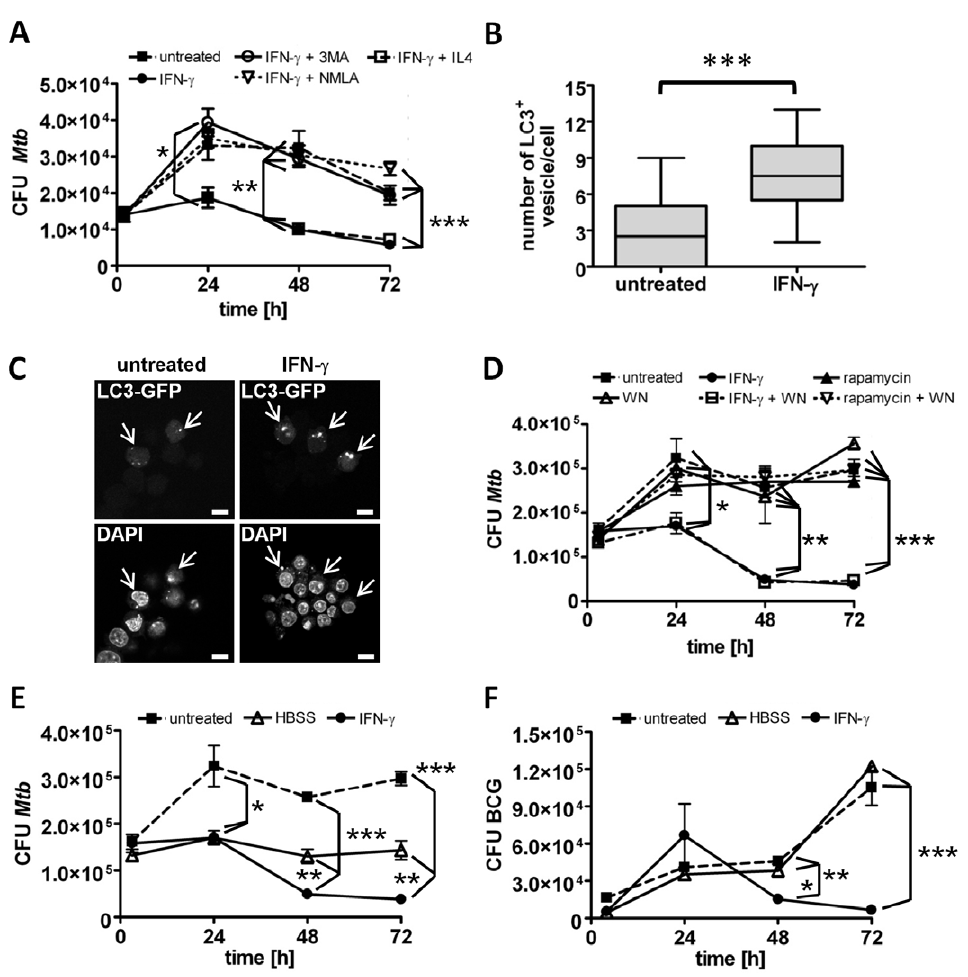
Figure 1. Autophagy does not affect mycobacterial survival in BMM W . Resting or IFN- c activated (2000 U/ml O/N) BMM W were infected with M. tuberculosis (MOI 1) or BCG (MOI 10) for 1 h, and subsequently treated with 3-MA (10 mM), NMLA (1 mM), IL-4 (50 U/ml), rapamycin (50 m g/ml), wortmannin (WM, 100 nM) or hanks balanced salt solution (HBSS). To determine mycobacterial survival, macrophages were lysed every 24 h and serial dilutions were plated onto agar plates for CFU determination (A, D–F). Data represent means 6 SD of triplicate cultures from one representative experiment out of three. Statistical analysis was performed by ANOVA (* p , 0.05; ** p , 0.01; *** p , 0.001). B and C) Untreated or IFN- c activated (2000 U/ml for 6 h) RAW 264.7 cells expressing eGFP-LC3 were analyzed by confocal microscopy for the number of LC3-positive vesicles 4 h post infection with BCG (MOI 10). Corresponding cells are labeled with arrows. B) Data from one out of two independent experiments are shown as means 6 SD (n=30 cells). Statistical analysis was performed by students t -test (*** p , 0.001). Representative confocal images are shown in C. Scale bar 10 m m.